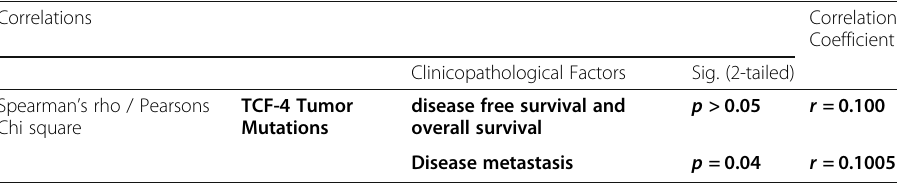
Table 6 Effect of Gene mutations on Survival of CRC patients